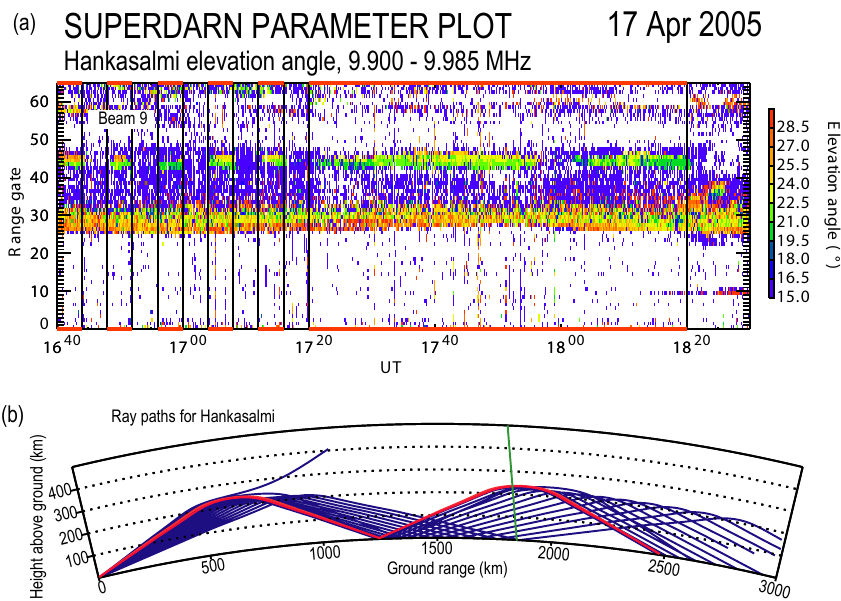
Fig. 5. (a) The elevation angle of the backscatter shown in Fig. 3, presented in the same format. (b) A raytrace of the HF propagation path for the transmission displayed in Fig. 3 and panel (a). The green line indicates the location of the field line intersecting the SPEAR location, whereas the red rays correspond to the elevation angles measured in panel